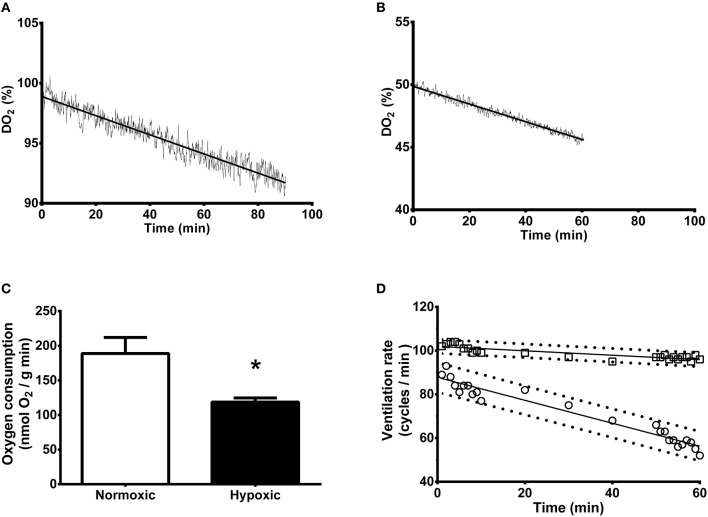
Whole animal rate of oxygen consumption and ventilation of Sepia officinalis under either normoxic or hypoxic (50% dissolved oxygen saturation, 1 h) conditions. (A) Dissolved oxygen saturation concentration (DO2) variation expressed as percentage over a 90 min sampling time in cuttlefish exposed to 100% DO2 (control). (B) Dissolved oxygen saturation concentration (DO2) variation expressed as percentage over a 60 min sampling time in cuttlefish exposed to 50% DO2 (mild hypoxia). (C) Oxygen consumption expressed as nmol O2/(g wet weight animal) min. *Indicates a statistically significant difference between normoxic and hypoxic conditions (2 tailed t-test; P = 0.025). N = 6 for normoxic and N = 5 for hypoxic conditions. (D) Ventilation rate expressed as cycles/min. Control, circles; Hypoxic, squares. N = 4 for all time points. The slopes are significantly different (P < 0.001).